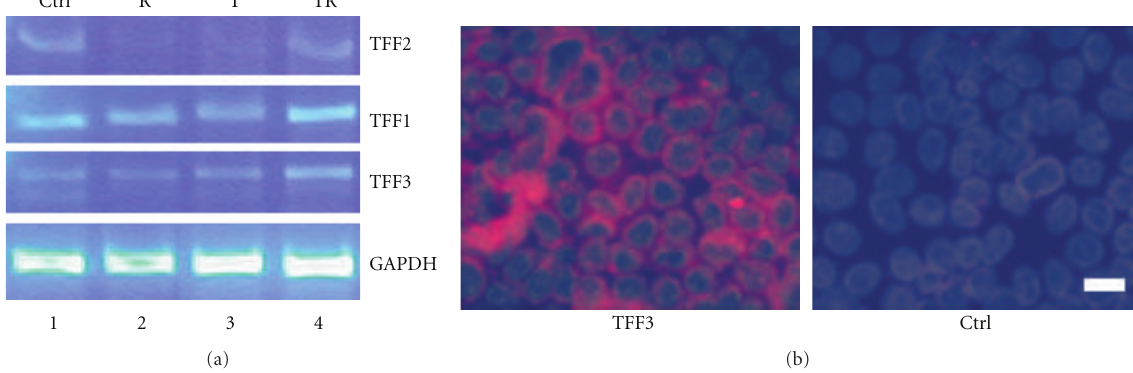
Figure 6: Mucin chaperones are inducible in cultured mouse middle ear epithelial cells. (a) TFF1, TFF2, and TFF3 are barely detected by reverse transcription polymer chain reaction (RT-PCR) in cultured mouse middle ear epithelial cells and are induced by TNF α and RA for two weeks (TR). (b) TFF3 is induced by TR treatment for two weeks as judged by immunohistochemistry. Ctrl, control; bar = 5 μ